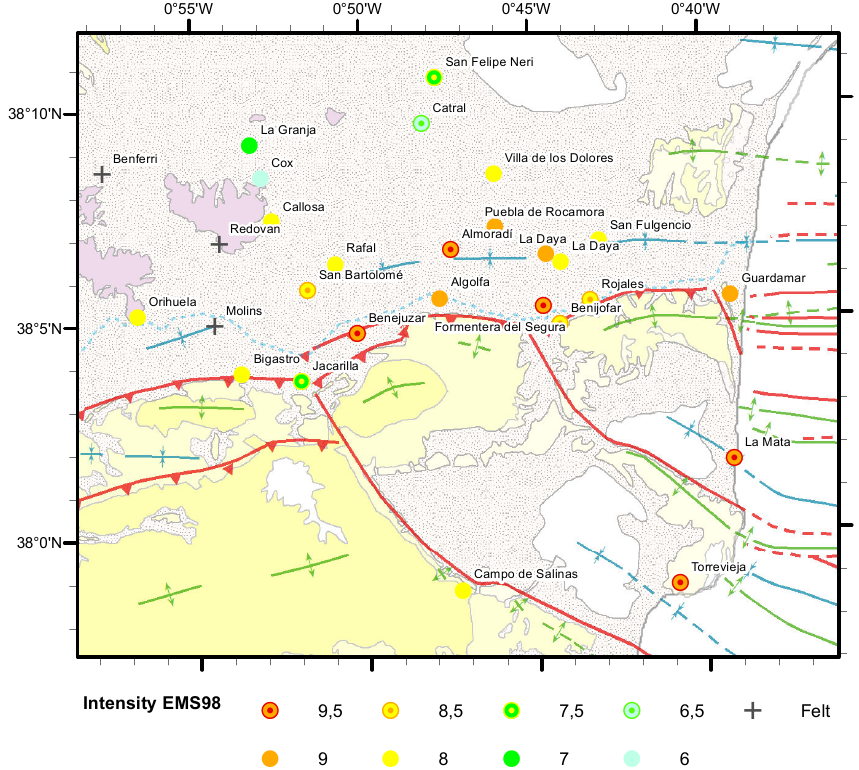
Fig. 10. Geological map of the Bajo Segura basin (Alfaro et al., 2002a, b) showing the distribution of the intensity data points of the 21 March 1829 Torrevieja earthquake (Mart´ınez Solares and Mezcua, 2002). Note that the area where the maximum intensities are located suggests that the BSFZ or the TF are the most likely sources of this